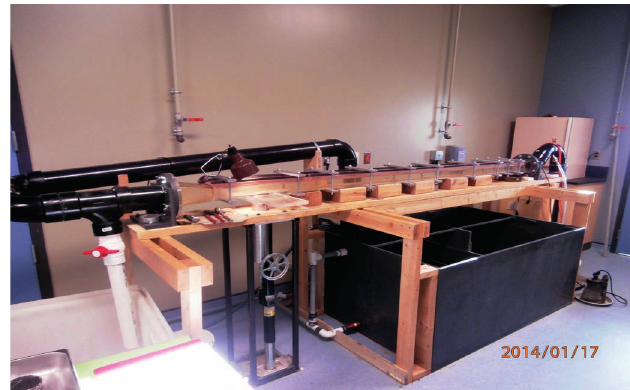
Fig. 4 Erosion measurement